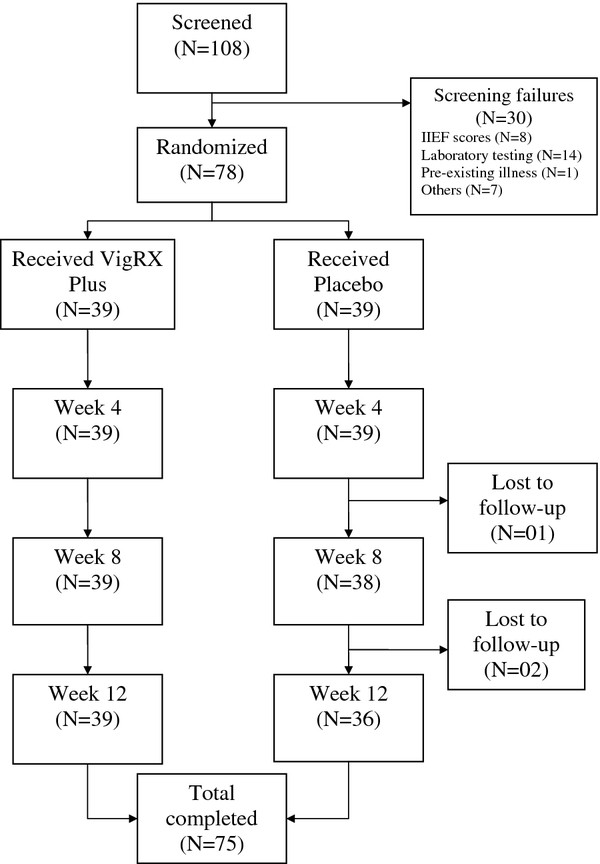
 Flow of participants.